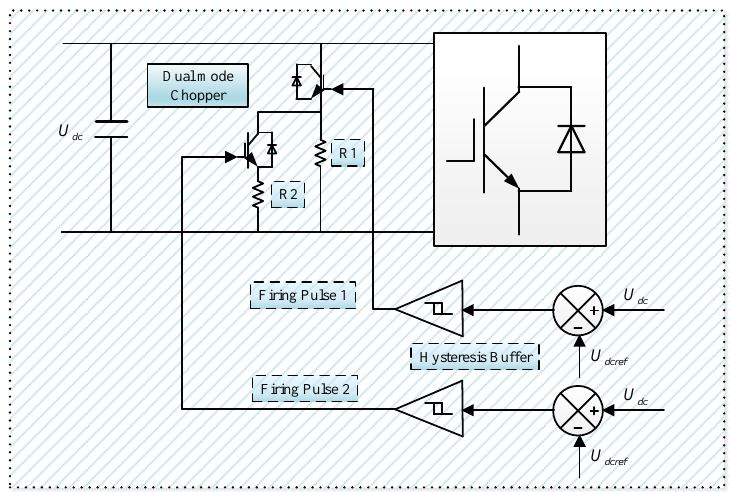
Figure 5. Configuration and control strategy of dual mode chopper circuits.